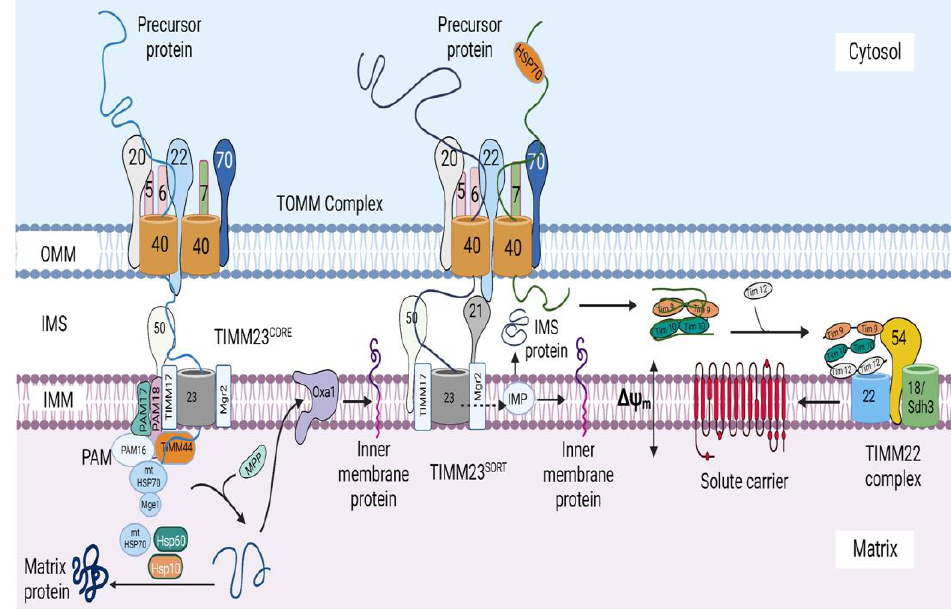
Figure 5. Import of inner-mitochondrial membrane and matrix proteins. The presequence-carrying precursors are first recognized by TOMM20, which binds to them and transfers them to TOMM22, after which they are translocated through the TOMM40 channel, through which they enter the IMS, where they bind to the IMS domain of TOMM22. TIMM21 then binds the IMS domain of TOMM22, thereby promoting the dissociation of the precursors. Thereafter, TIMM50 binds to the precursor proteins and transfers the precursors into the TIMM23 channel. The Δψm exerts an electrophoretic effect on the positively charged N terminus of precursors and activates the TIMM23 channel, thereby aiding in the movement of the precursors through the TIMM23 channel. The hydrophobic sorting signals of the precursors are then recognized by Mgr2, which then binds to the sorting signals and controls the release of the precursors into the inner membrane. Subsequently, the inner-membrane peptidase (IMP) removes the hydrophobic sorting sequences, and the mature proteins are either released into the IMS or remain anchored in the inner membrane by an additional hydrophobic segment. Precursor proteins containing presequences devoid of hydrophobic sorting signals are destined for the matrix and are imported through the cooperation of the TOMM, TIMM23 CORE , and PAM machineries. After translocation through the TOMM40 channel, these precursors bind to the IMS domain of TOMM22, after which TIMM50 binds these precursors and transfers them to the TIMM23 channel. TIMM44 then binds to the precursor as it emerges on the matrix side of the TIMM23 channel and transfers it to mtHsp70, which imports the protein into the matrix. The presequences are removed by the matrix processing peptidase (MMP), and the proteins are folded into their mature forms by the soluble form of mtHSP70 and the HSP60-HSP10 chaperonin complex. Oxa1 aids in the export of some of the transmembrane segments of some inner-membrane precursors from the matrix into the inner mitochondrial membrane. Following their synthesis in the cytosol, carrier precursors are bound to cytosolic chaperones of the Hsp70 and Hsp90 classes to prevent aggregation. Thereafter, these chaperones deliver the precursors to TOMM70, which then transfers this precursor to TOMM22, after which they are transferred to the TOMM40 channel and translocated across the OMM in a loop formation. The small TIM chaperones of the IMS are recruited to the channel exit by an N-terminal segment of the channel protein TOMM40. TIMM54, a subunit of the TIMM22 machinery, recruits the small TIMM chaperones to the TIMM22 complex, after which, the precursors are delivered to the TIMM22 channel. The Δψm activates the TIMM22 channel and exerts an electrophoretic effect on the carrier precursors, which aids in the movement of the precursors through the channel. Finally, the precursors are released laterally from the TIMM22 complex into the IMM. OMM, outer mitochondrial membrane; IMM, inner mitochondrial membrane, IMS, intermembrane space; Δψm, mitochondrial membrane potential. The figure was created with Biorender.com.